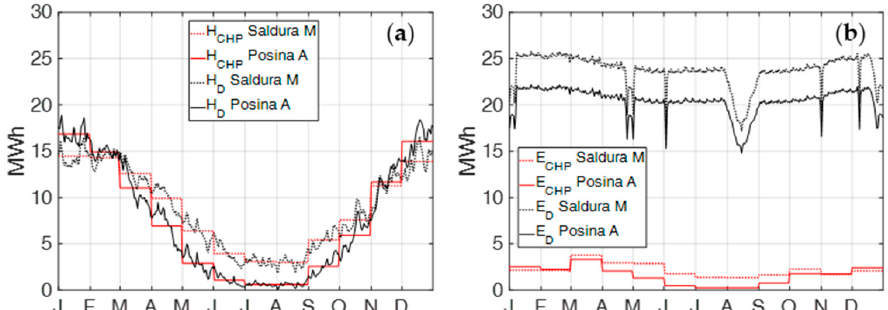
Figure 2. ( a ): Seasonal heat demand and CHP heat generation for the districts of Posina at Stancari (reported as Posina A, catchment #2 in Figure 1) and Saldura at Mazia (reported as Saldura M, catchment #14 in Figure 1). ( b ): Seasonal electricity demand and CHP electricity generation for Posina at Stancari and Saldura at Mazia. Note: the average cycles are obtained over the period 2000–2008. Heat demand values are smoothed by applying a 10-days moving window. Significant decreases in electricity demand follow from major holiday periods in Italy.